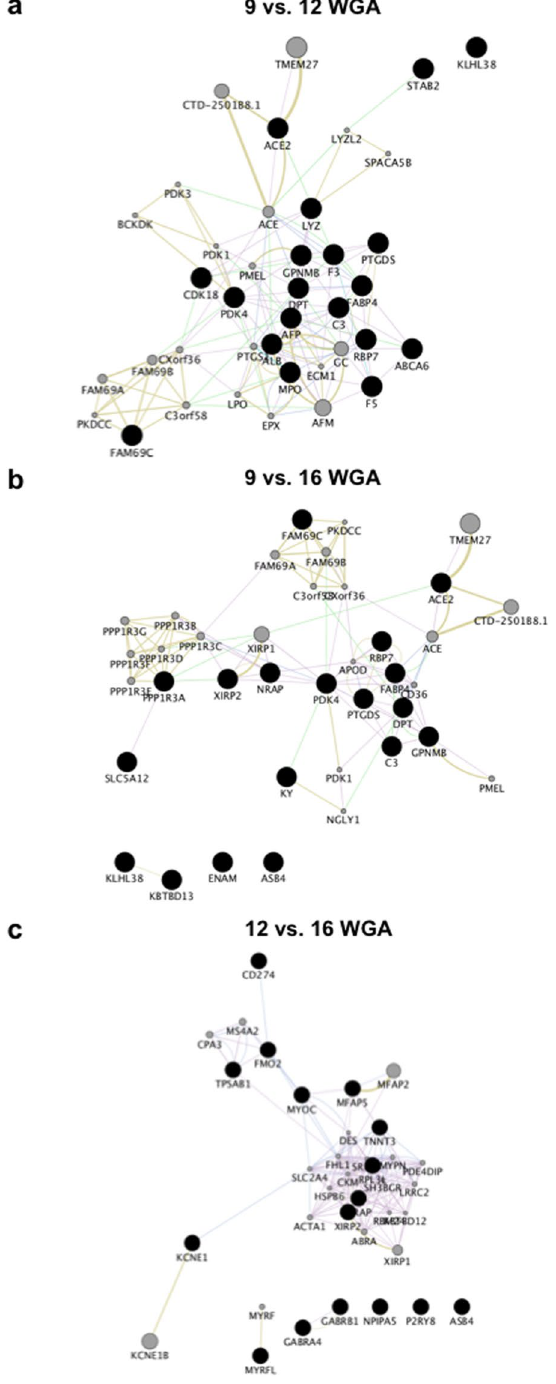
Figure 2. Predictive gene network analysis for significantly upregulated genes. The 20 genes with the greatest log2 fold increase between age comparisons (black circles; nodes) were used to identify functional connectivity within the network. Connectivity predictions (lines; edges between nodes) were facilitated by identifying 20 additional genes (grey circles) of known gene-gene or protein-protein interactions that best create a functional network to identify hub nodes. ( a – c ) Network analysis for 9 compared to 12 weeks gestation age (WGA), 9 compared to 16 WGA, and 12 compared to 16 WGA. Note for all analysis, some genes did not have known interactions to the networks, and hence sit unconnected to the network (e.g. bottom of c ). Edges are colour coded to signify the predicted connections between nodes; co-expression: purple; co-localisation: blue; genetic interactions: green; shared protein domains: yellow; predicted: orange; physical interactions: pink; pathway: light